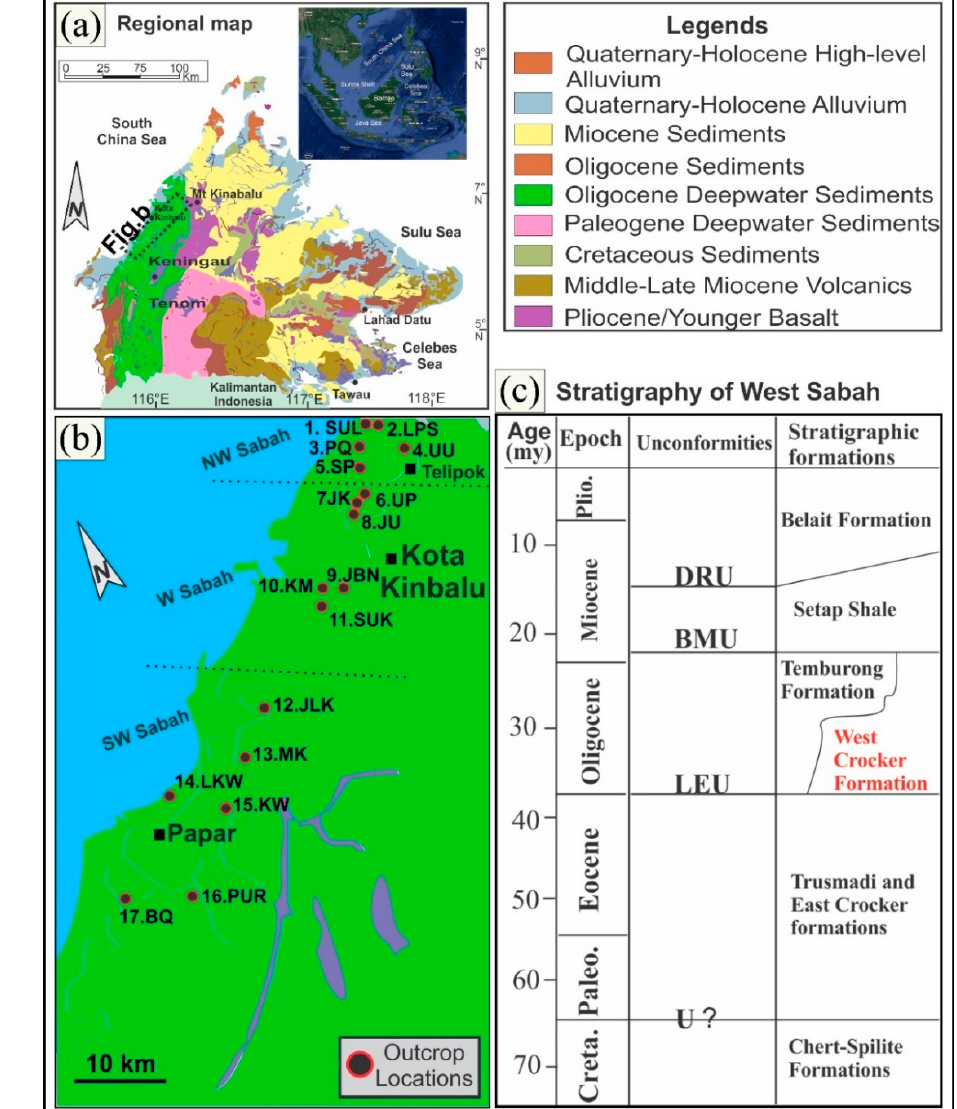
Figure 1. Study area in Sabah, NW Borneo. ( a ) Map of Borneo with surrounding archipelagos with stratigraphic record in the legend outlined with black rectangle showing the study location of Sabah. ( b ) Study area with various regions in Sabah selected for the fieldwork, where locations 1–5 are around Telipok (NW Sabah), locations 6–11 around the Kota Kinabalu (West Sabah), and 12–17 around Papar Town (SW Sabah). ( c ) Stratigraphic position of the sand-rich West Crocker Fan majorly related to the Oligocene age and bound by the Late Eocene Unconformity (LEU) at the base while the upper contact is marked by the Base Miocene Unconformity (BMU).